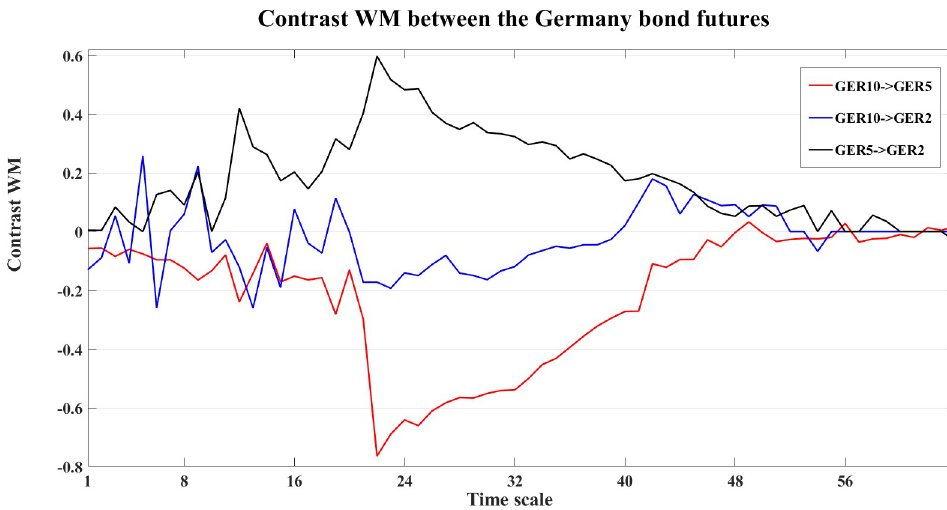
Fig 32. The contrast WM information transfer values for the Germany bond futures. The line graphs show the contrast WM values between the Germany bond futures at different time scales s i (i = 1,2, ... 64).